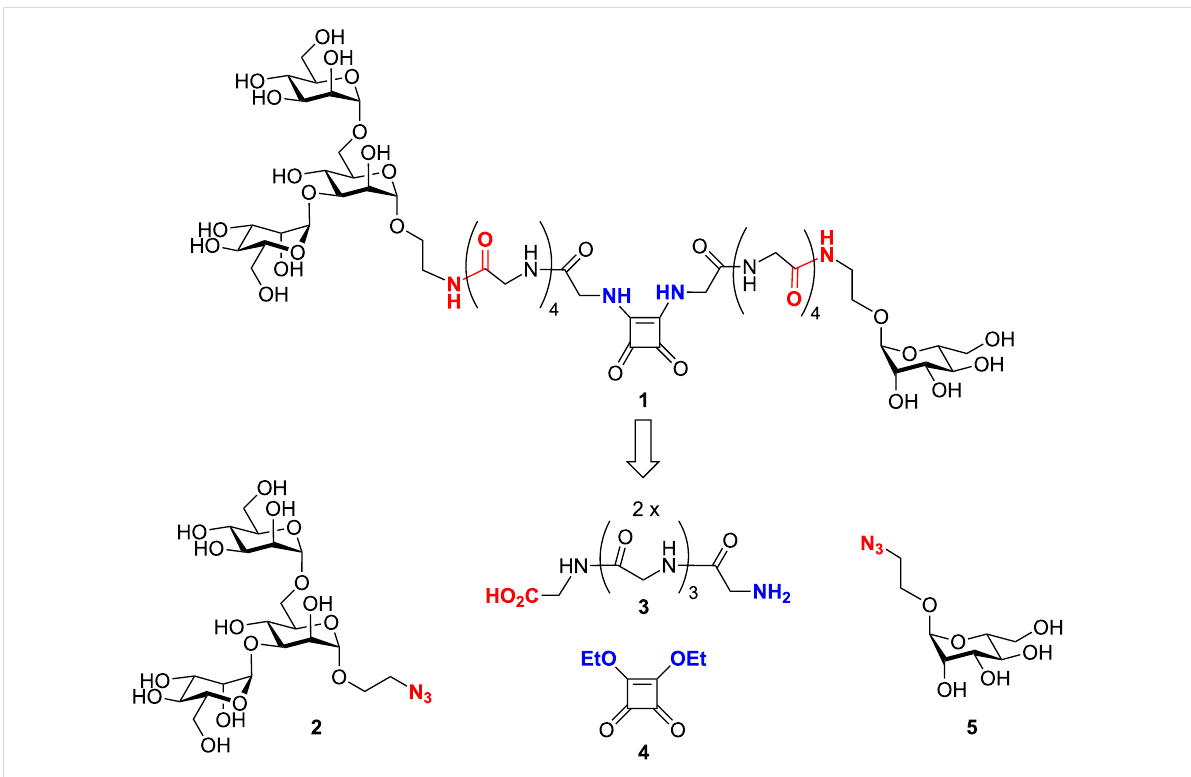
Figure 2: The bivalent glycopeptide 1 is the target molecule to test the hypothesis of two carbohydrate binding sites on FimH. Its retrosynthesis delivers the azido-functionalized mannotrioside 2 as the western part of the target structure and 2-azidoethyl mannoside 5 as its eastern portion. Squaric acid diethyl ester (DES, 4 ) can link both parts via two pentaglycine spacers ( 3 ).